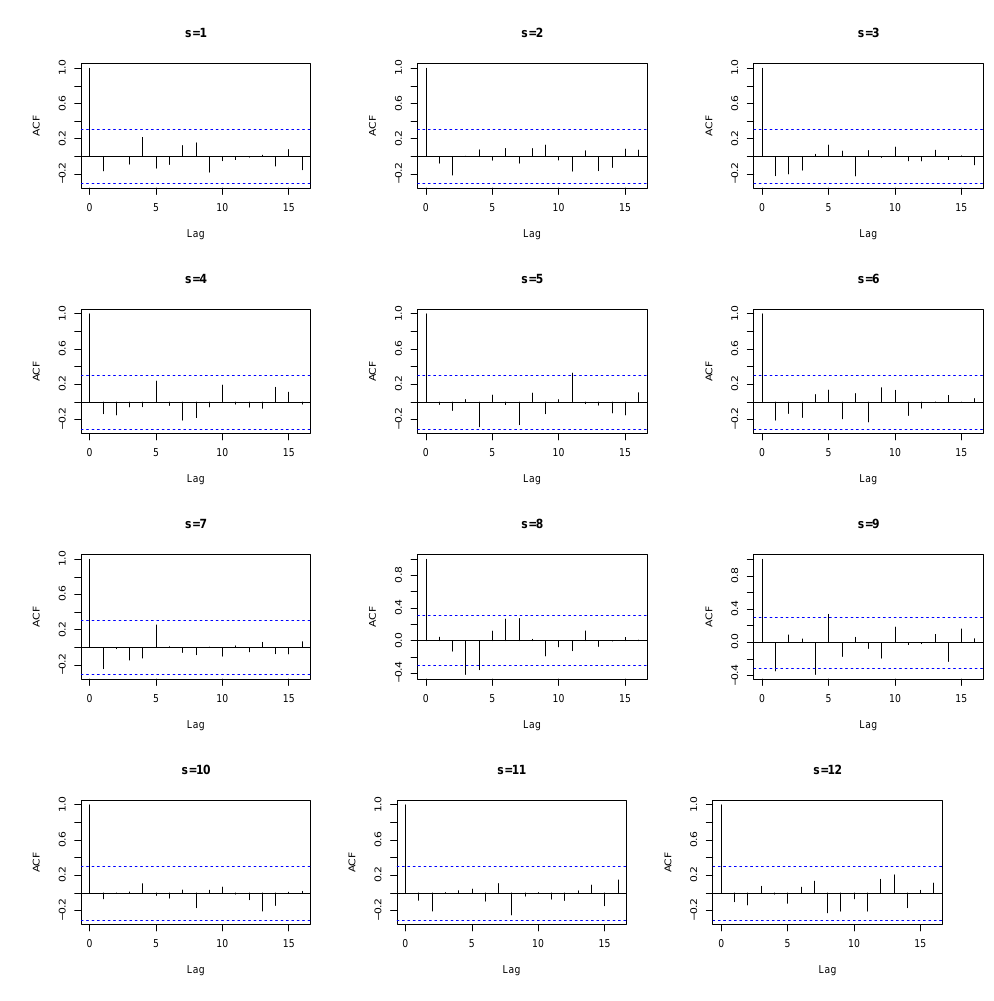
Figure 6. Autocorrelation graph of residual sequences from January ( s = 1) to December ( s = 12). We also compare the robust estimation procedure (LAD, EXP and HB) with OLS to illustrate the proposed mehtod. Further, to implement our approach, the unknown function g ( · ) is approximated by a cubic B-spline function with equispaced knots. The truncation parameters J and K are selected by the BIC method and calculated according to Equation (13) in Section 2. Similar to Aneiros and Vieu [10] and Yu et al. [27], the following two error criteria, mean quadratic error (MQE):